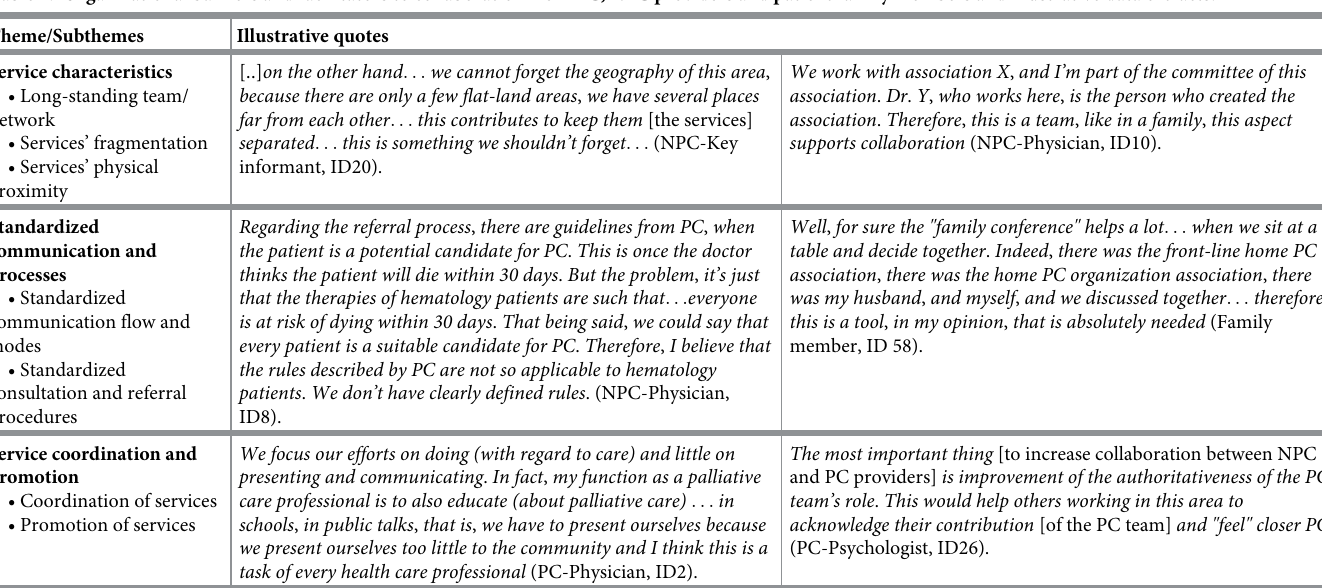
Table 4. Organizational barriers and facilitators to collaboration from PC, NPC providers and patient family members and illustrative data